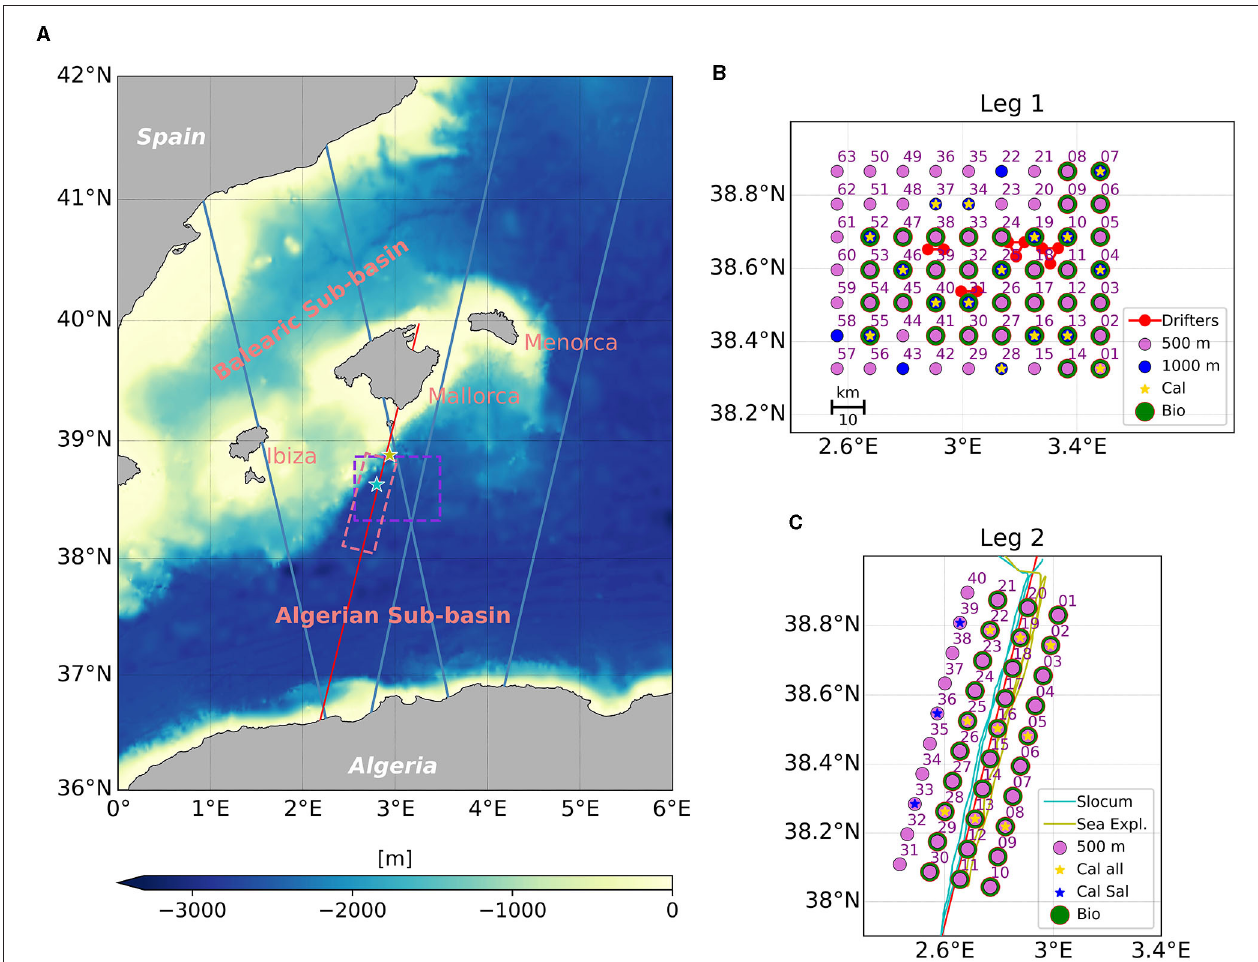
FIGURE 1 | (A) Bathymetric map of the study region. Purple and pink boxes show the regions sampled during Leg 1 and Leg 2, respectively, of the PRE-SWOT field experiment. Blue solid lines represent the limits of future SWOT swaths during the fast-sampling phase. Red line shows the Sentinel-3A ground-track 244 that passed over the Balearic Sea on 13 May 2018. Cyan and green stars represent the position of the Slocum and SeaExplorer gliders, respectively, during the satellite pass. (B) Leg 1 sampling strategy. (C) Leg 2 sampling strategy. Red line represents the Sentinel-3 track 244 passover on 13 May 2018. Cyan and green lines show the routes of the Slocum and SeaExplorer gliders, respectively, following the satellite track from 5 to 14 May 2018. In the legends: Cal and Cal all, water samples collected to calibrate salinity, dissolved oxygen and chl-a fluorescence; Cal Sal, water samples collected to calibrate salinity; Bio, water samples collected for nutrient, pigment signature, and phytoplankton determination; 500 (1,000) m, CTD casts to a maximum depth of 500